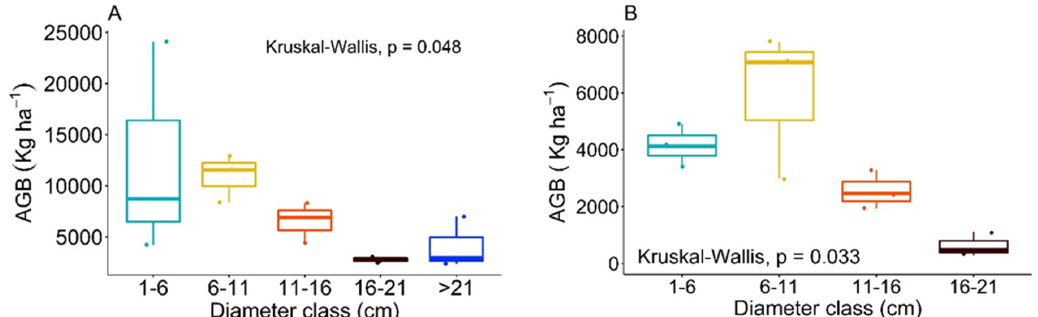
Figure 5. Statistical difference in aboveground biomass (AGB) across diameter class in two forest sites (OR - Oorani and PP - Puthupet): A) OR and B) PP, over nineteen